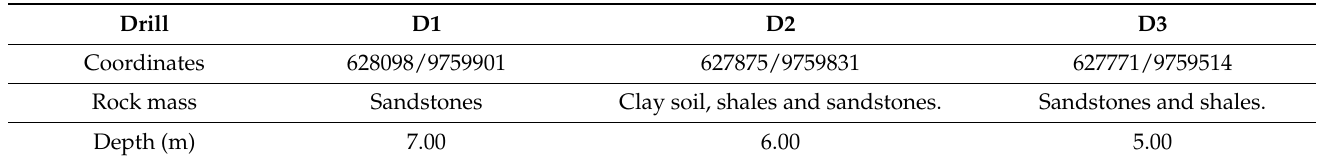
Table 10. Information of boreholes.